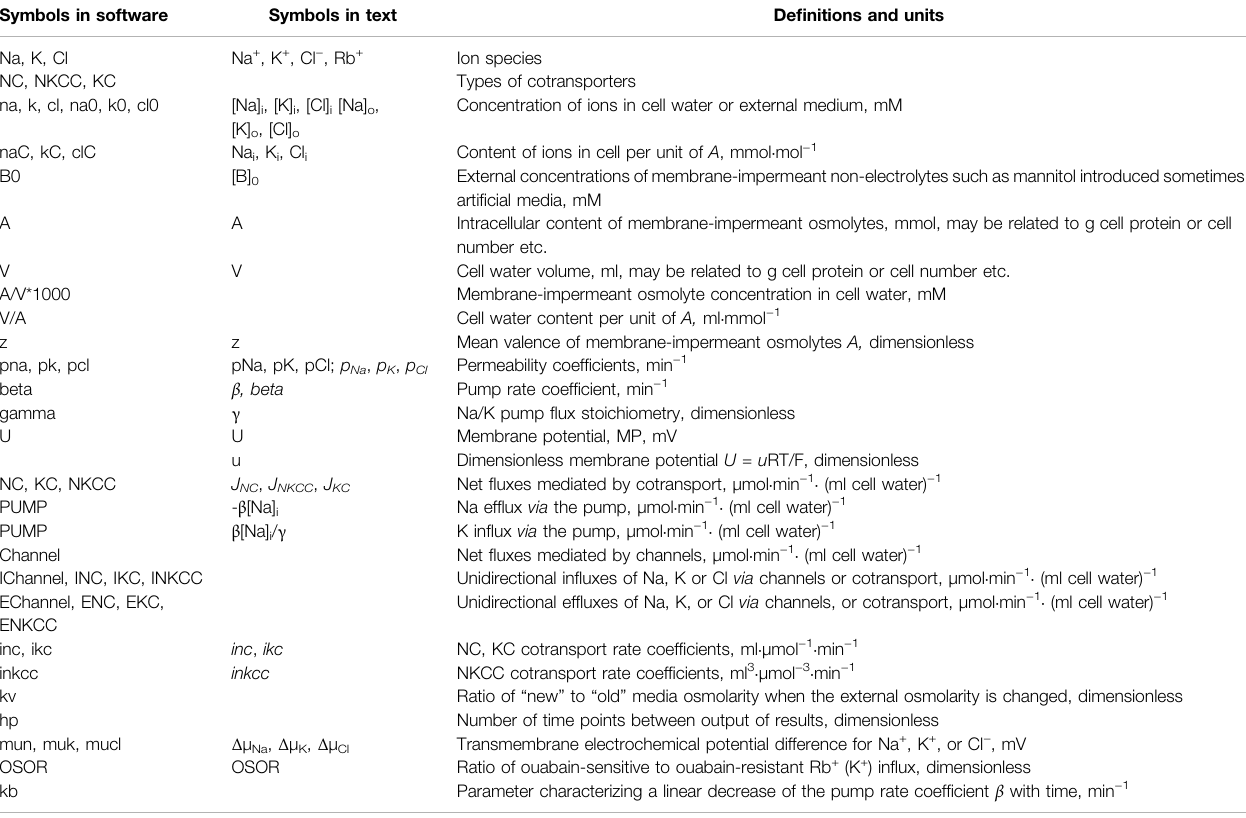
TABLE 1 | Symbols and de fi nitions. Symbols in software De fi nitions and